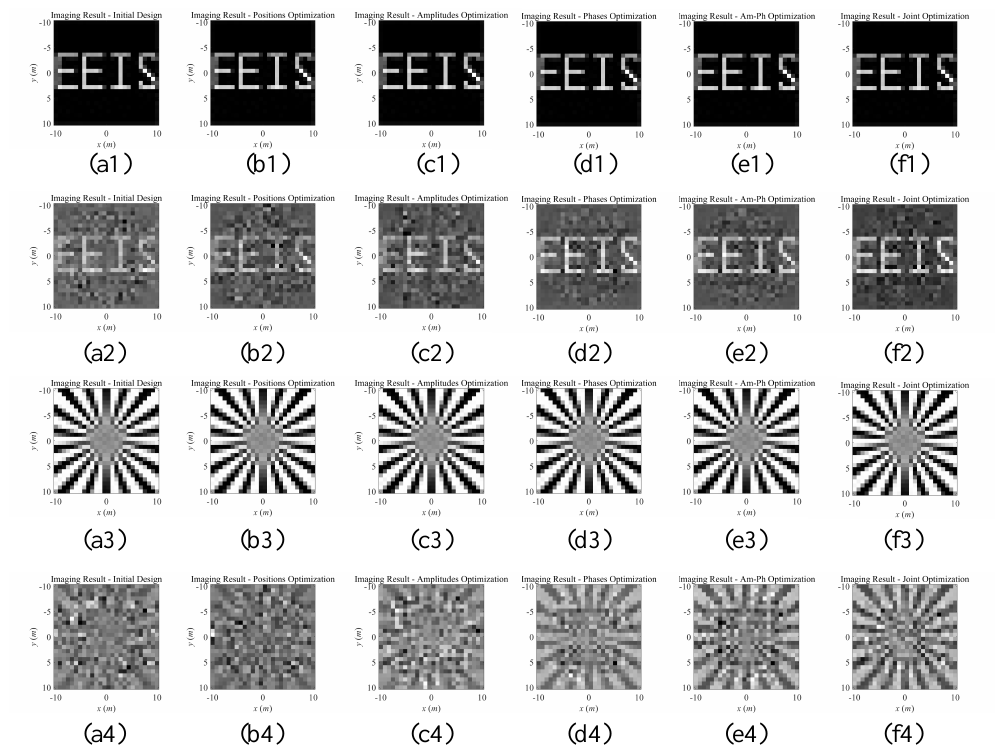
Figure 15. Imaging results of MSCI based on steady radiation fields sequence. (1) is results of target 1 under noise-free condition, (2) is results of target 1 under SNR = 20 dB noise, (3) and (4) are results of target 2 under noise-free condition and SNR = 20 dB noise, respectively. ( a ) represents original random designs of the parameters in SRFS-MSCI, ( b – d ) are results of optimized sensing matrix via changes on antenna positions, amplitudes, and phases, respectively. ( e ) is the results of joint optimization on amplitudes and phases, and ( f ) is the results of joint optimizations on all